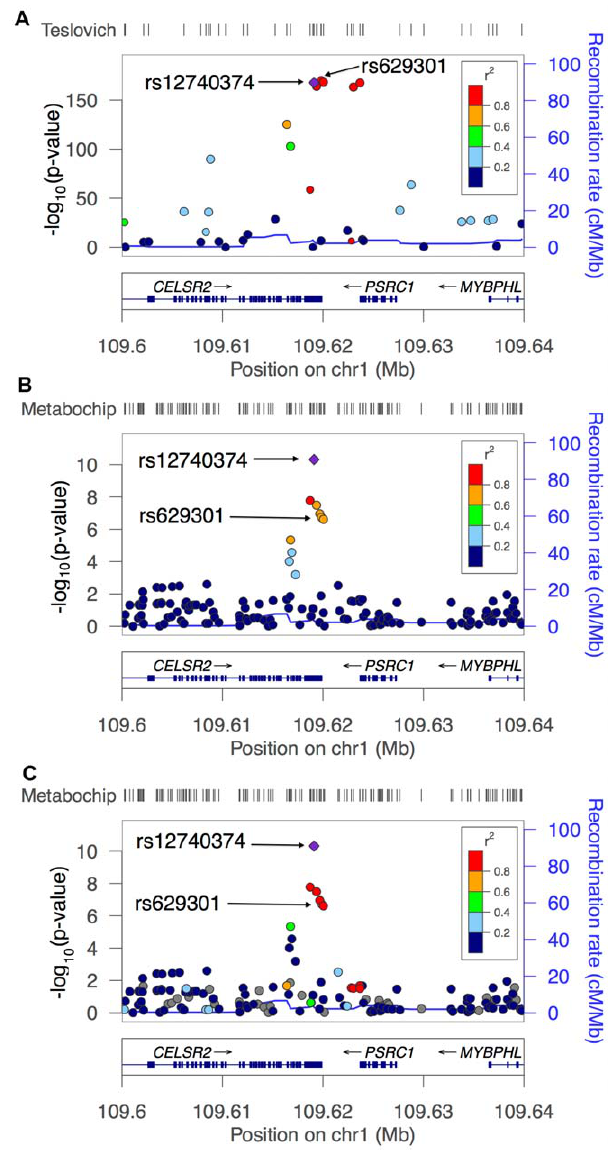
Figure 3. Regional association plots for LDL-C near the CELSR2/ PSRC1/SORT1 locus. The LDL-C association signal near the CELSR2/ PSRC1/SORT1 locus is narrower in African Americans than Europeans. (A) Association results from European-ancestry samples [13] colored by LD ( r 2 ) in CEU with rs12740374. (B) Association results in African Americans from PAGE colored by LD ( r 2 ) in the same sample with rs12740374; (C) The same association results as in (B) but colored by their correlation ( r 2 ) in the Malmo¨, Sweden, sample [32] with rs12740374. Positions shown are based on hg18. Recombination rate shown is based jointly on the CEU, YRI and JPT + CHB HapMap samples